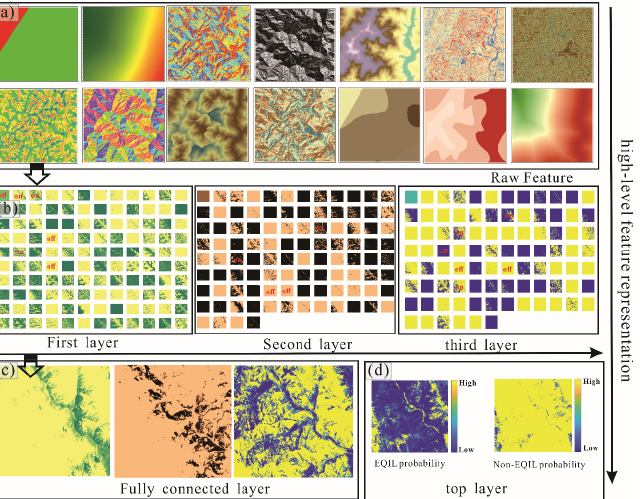
Figure 10. The feature extraction process of SAE. There are 178 blocks in whole study area. The 34th block is selected as an example of the feature extraction process:( a ) fourteen kinds of raw feature were derived from different datasets. ( b ) Abstract features in first, second, and third layers. ( c ) Weight matrix of fully connected layer. ( d ) The probabilities of EQIL and non-EQIL.